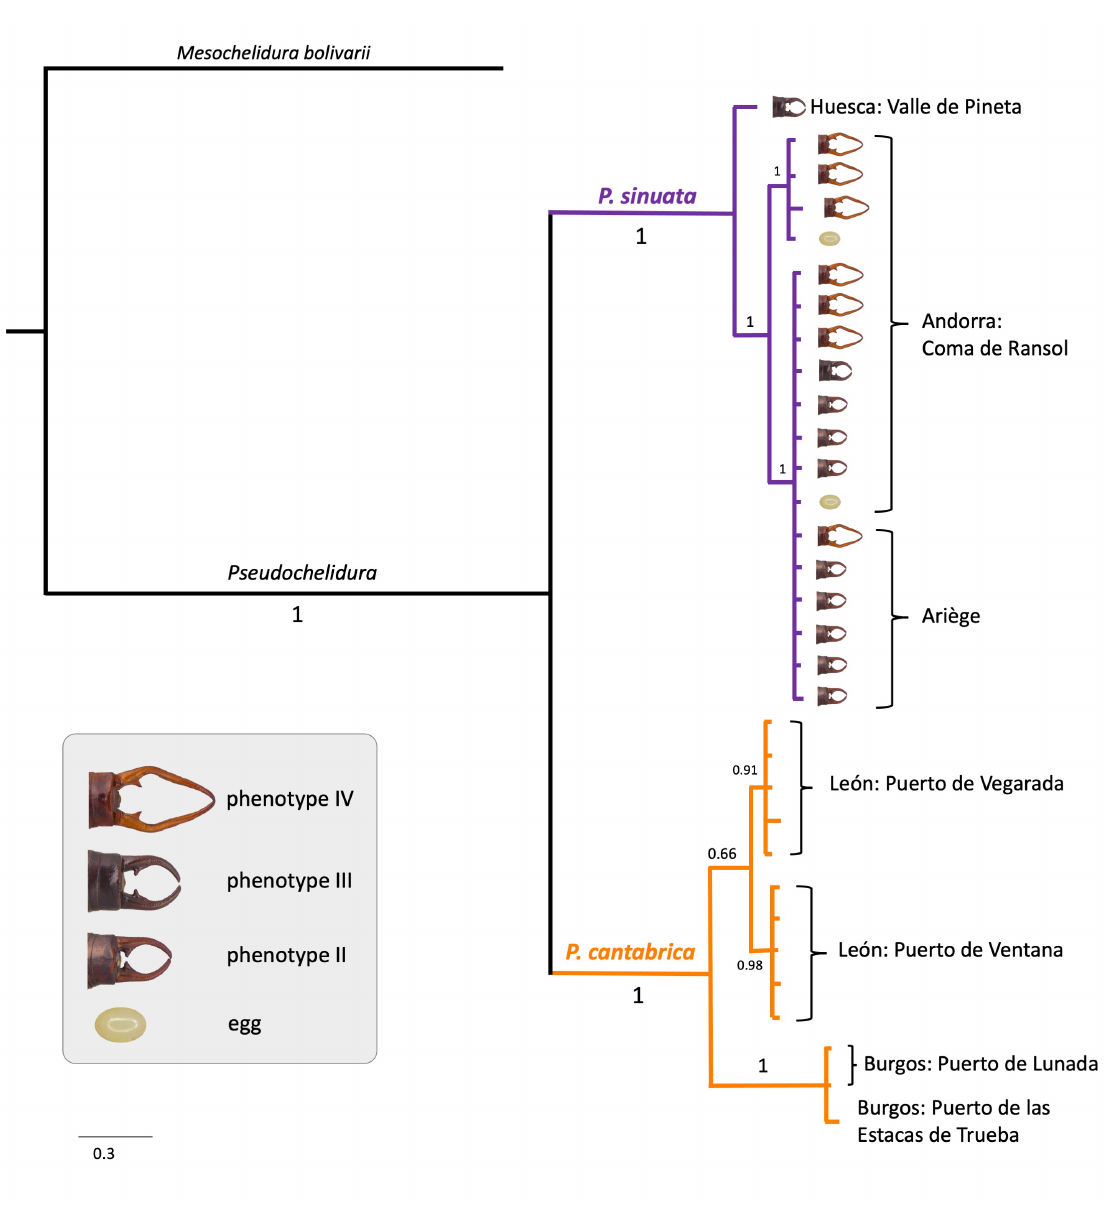
Fig. 1. Bayesian tree obtained using the concatenated mitochondrial-nuclear data set (cytb + ITS2). Independent analyses using cytb and ITS2 data provided totally congruent topologies. Posterior probabilities are indicated below branches. Branch colors represent the two species of Pseudochelidura Verhoeff, 1902 studied: P. sinuata (Germar, 1825) and P. cantabrica Cuesta-Segura, Jurado- Angulo & García-París sp. nov. A synthetic representation of the cerci phenotype of each analyzed male specimen of P. sinuata is represented next to its branch. The three phenotypes corresponded to the three previously recognized Pyrenean species of Pseudochelidura synonymized in this work ( P. sinuata = P. minor Steinmann, 1979 = P. montuosa Steinmann, 1981 syn. nov.). DNA from two eggs was also sequenced. Specimens of P. cantabrica used in the analyses covered all range of male cerci variability (see Fig.